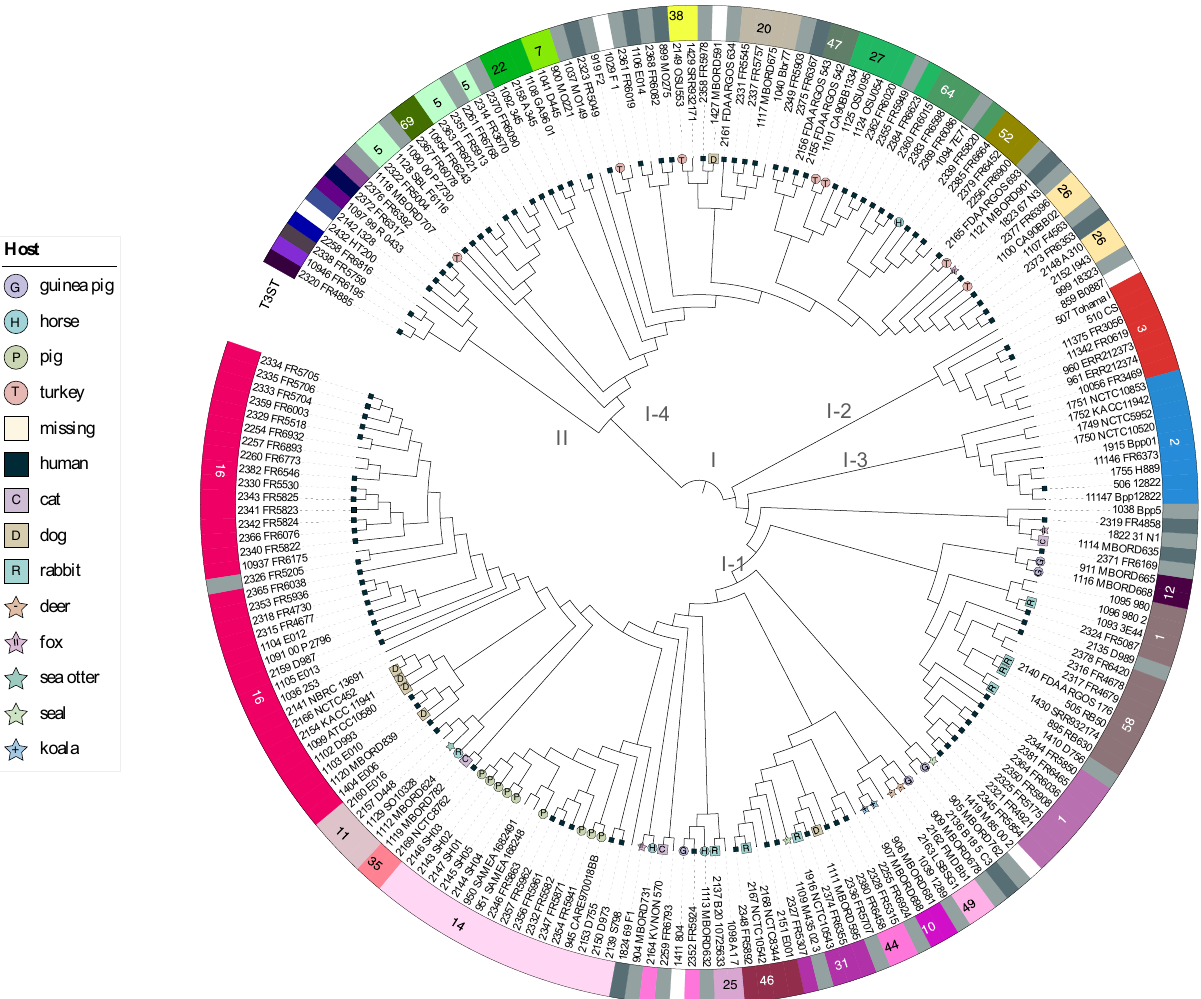
Fig. 2 Cladogram of the Bordetella bronchiseptica genomic species. The analysis was performed with 186 B. bronchiseptica genomes, and representatives of the phylogenetic diversity of B. pertussis (9 genomes) and B. parapertussis (9 genomes). The recombination-purged concatenated multiple sequence alignment of 1415 core gene loci ( cgMLST_genus scheme) was used. The tree is rooted on lineage II, which is the most divergent clade. Branch lengths were not used to ease readability of groups and isolates; see Supplementary Fig. 5 for the corresponding phylogram. For each isolate, the host is represented using a leaf symbol, where available (see key in Supplementary Fig. 5). The numbers corresponding to T3SS sequence types are indicated along the external circle around the tree; only the identi fi ers of main T3STs are indicated. An interactive iTOL version of the tree can be accessed at: https://itol. embl.de/shared/1l7Fw0AvKOoCF. Source data are provided as a Source Data fi